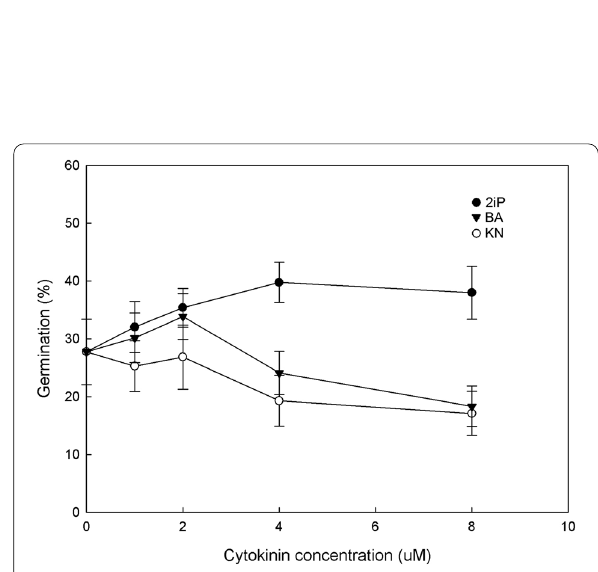
Fig. 5 Effects of various cytokinins on seed germination of C. subtropicum after 6 months of culture. Error bars represent SE